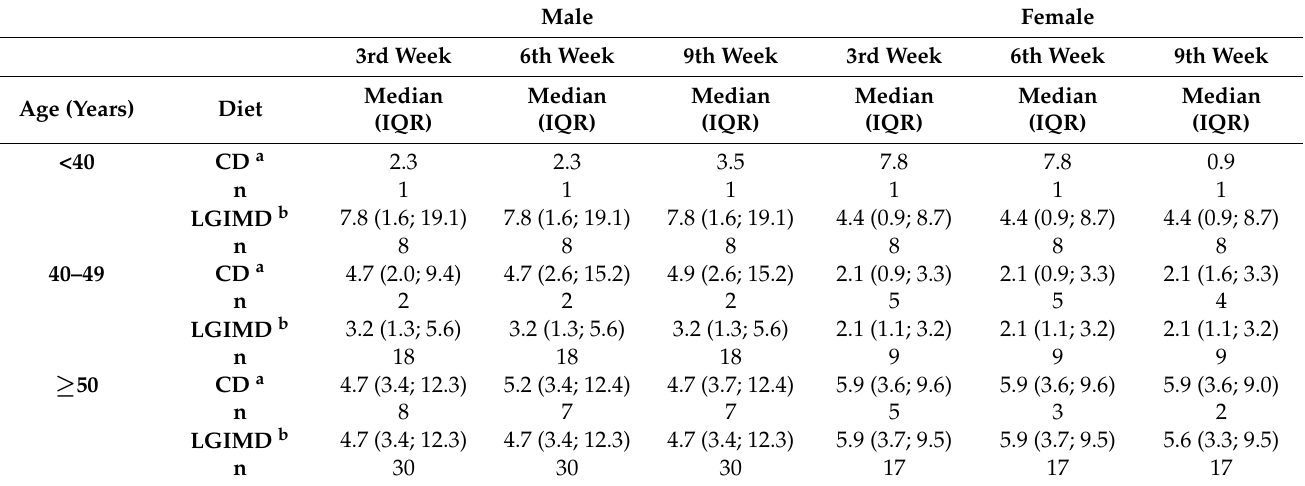
Table 5. Mediterranean Adequacy Index by Gender, Age, and Week. NutriAtt Trial, Castellana Grotte, 2015–2016.